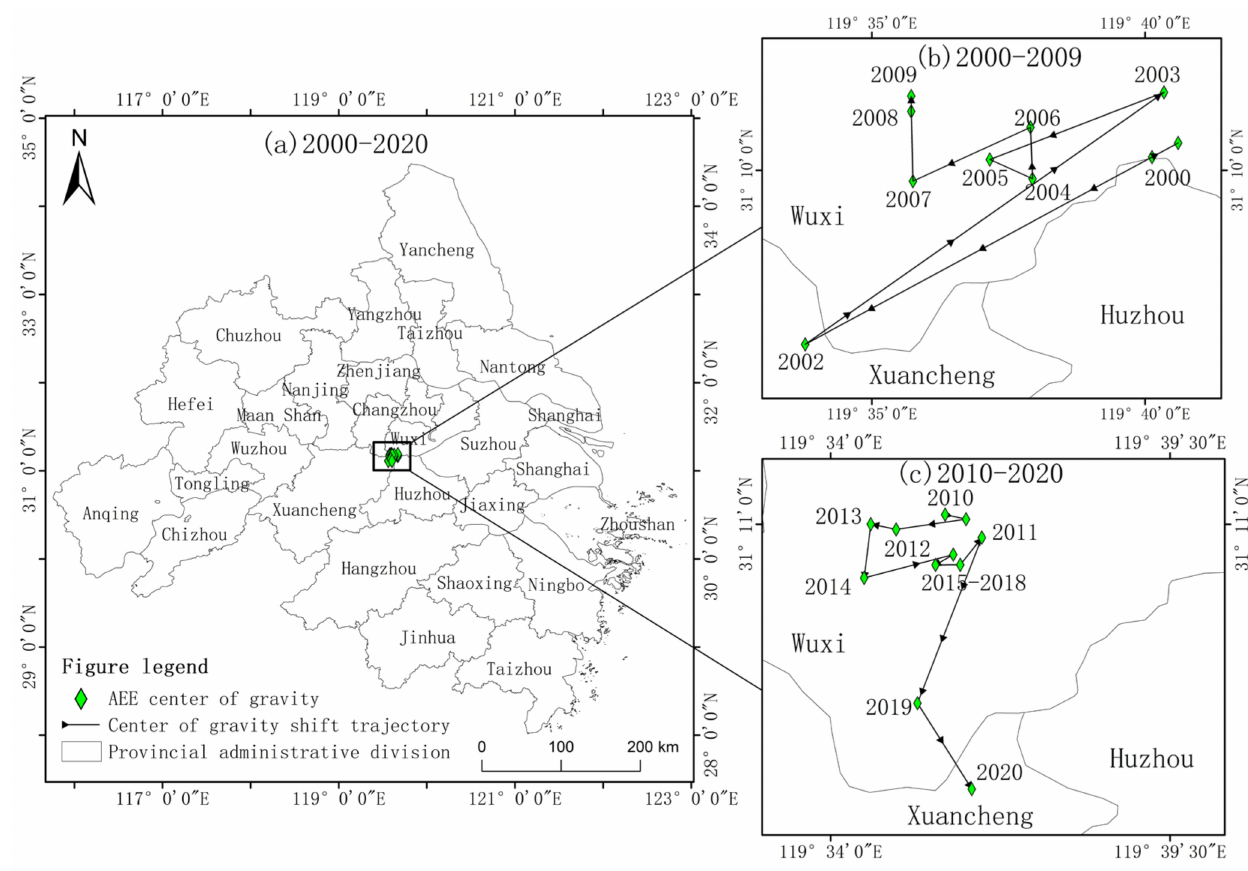
Figure 5. The center of gravity shift of AEE in the YRD from 2000 to